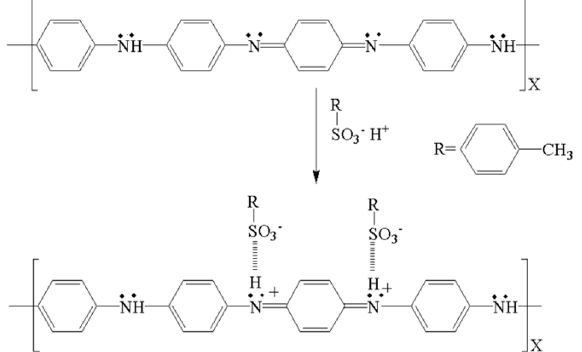
Figure 3. The scheme of PANI doped with P-TSA.